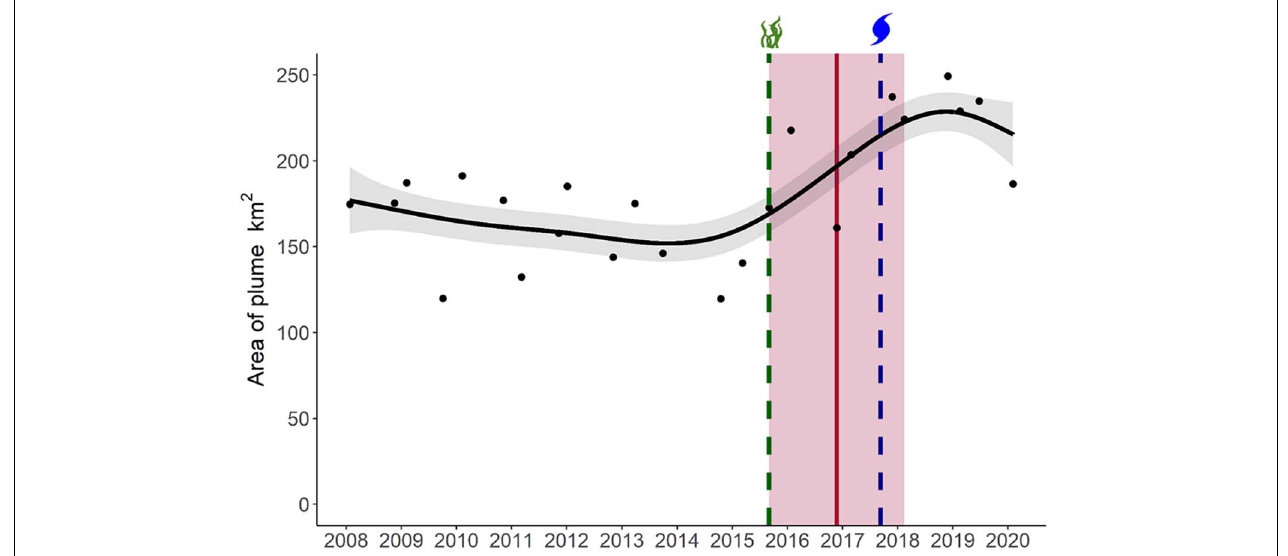
FIGURE 4 | Temporal trend in the sediment plume size in Florida Bay between 2008 and 2020. The black line shows the fitted GAM model and 95% confidence interval (gray shaded area). The vertical red line shows the breakpoint in sediment plume size, with its 95% confidence interval (red shaded area). The vertical green line represents the 2015 seagrass die-off and the vertical blue line represents Hurricane Irma.